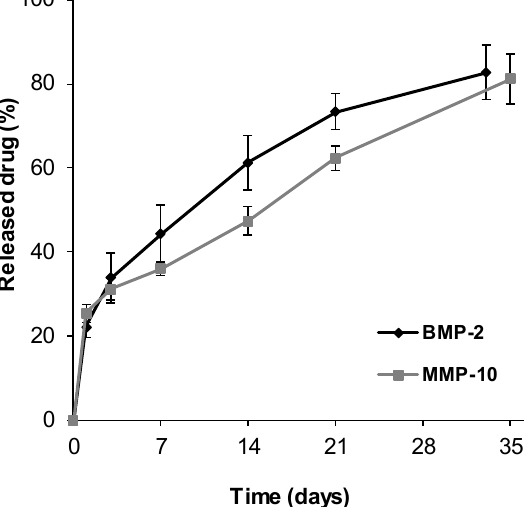
Figure 8. In vivo BMP-2 and MMP-10 release at different time points after implantation of the